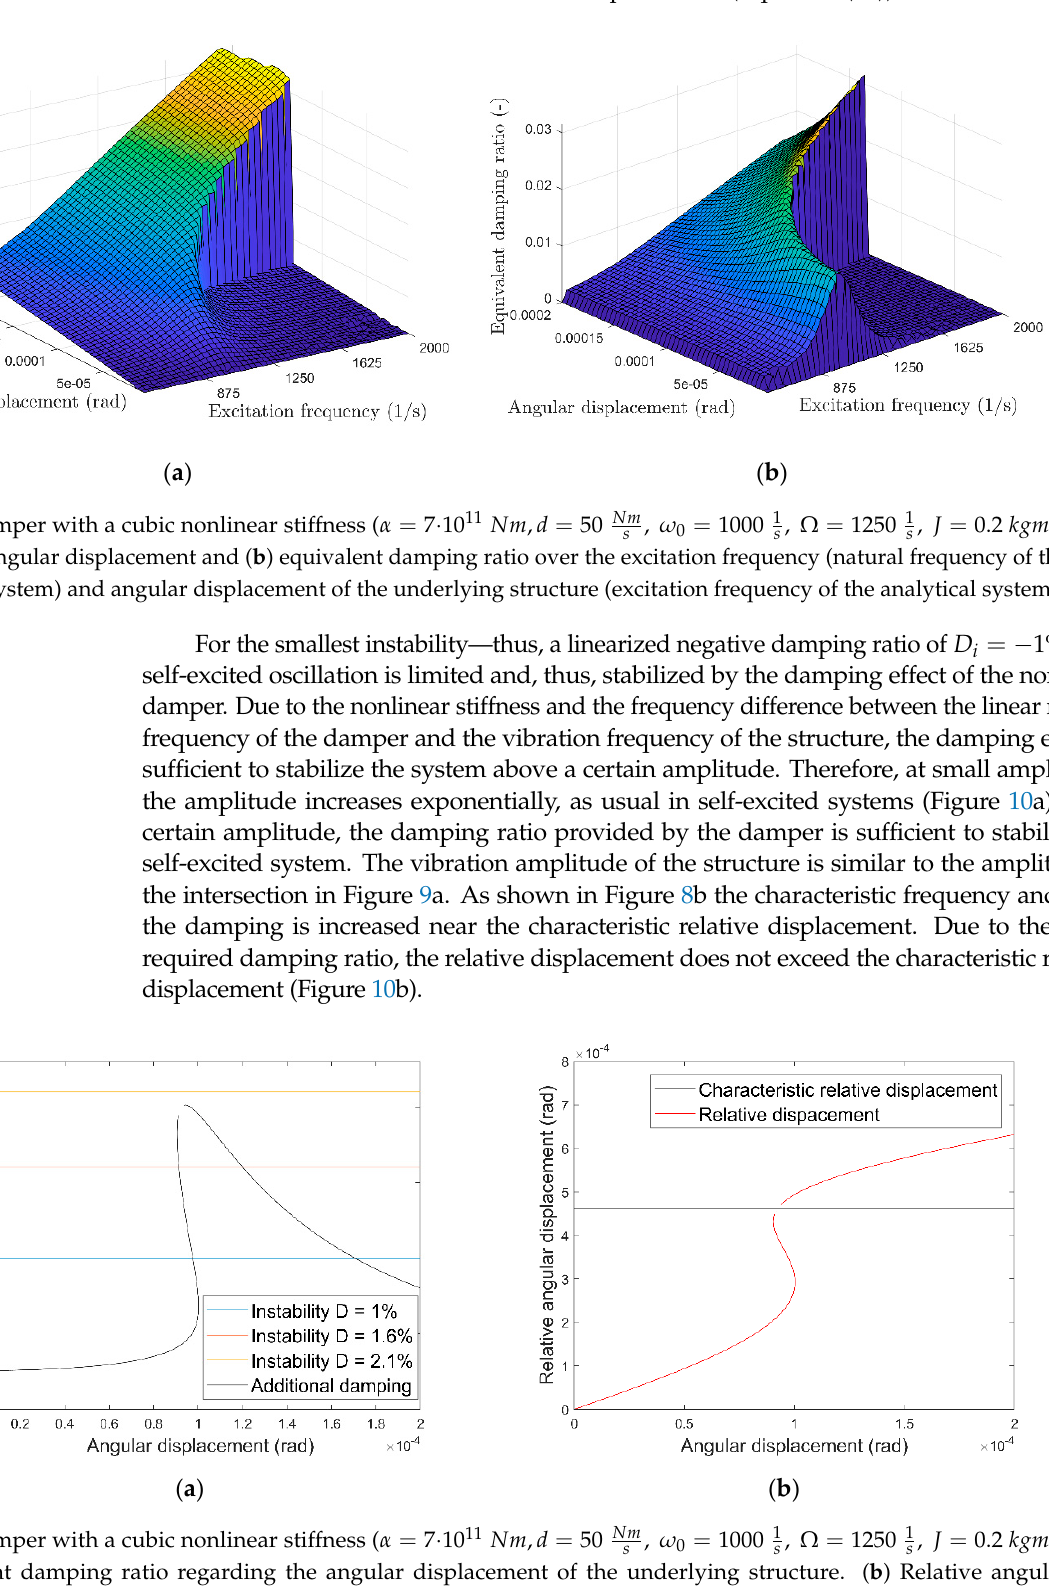
Figure 9. Damper with a cubic nonlinear stiffness ( α = 7 · 10 11 Nm , d = 50 Nm ( a ) Equivalent damping ratio regarding the angular displacement of the underlying structure. ( b ) Relative angular displacement regarding the angular displacement of the underlying